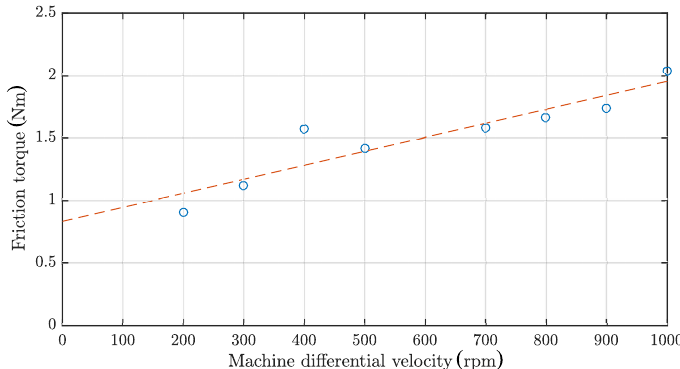
Figure 14. Designed machine friction torque in the function of relative rotational